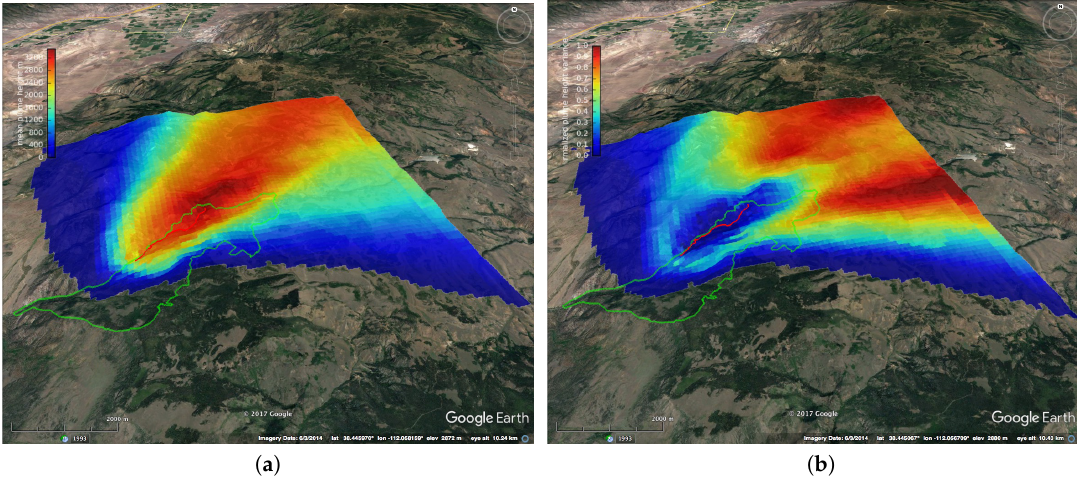
Figure 14. ( a ) The mean plume top height; ( b ) The normalized variance in the plume height. The green contour represents the burning plot boundary and the red line shows the ignition.